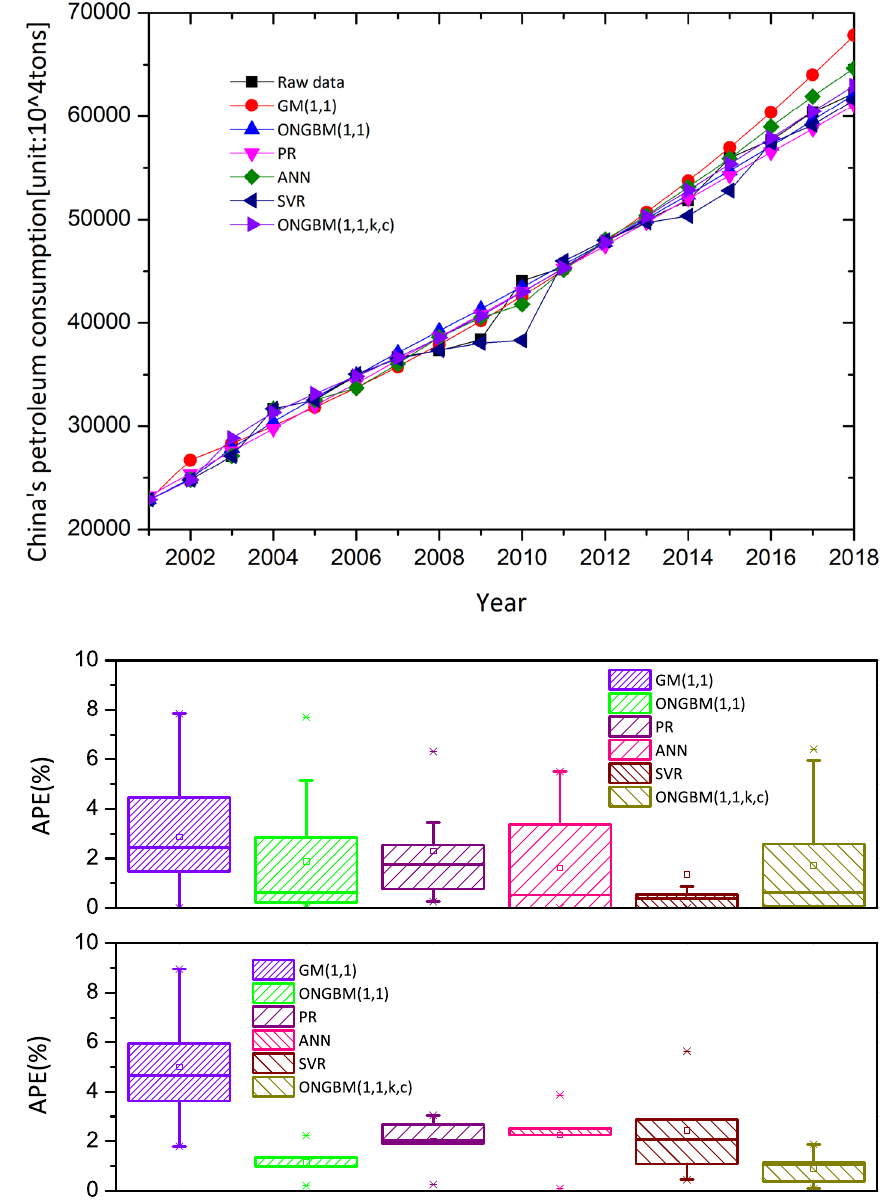
Fig. 4 Comparison of forecasted and actual values from 2001 to 2018